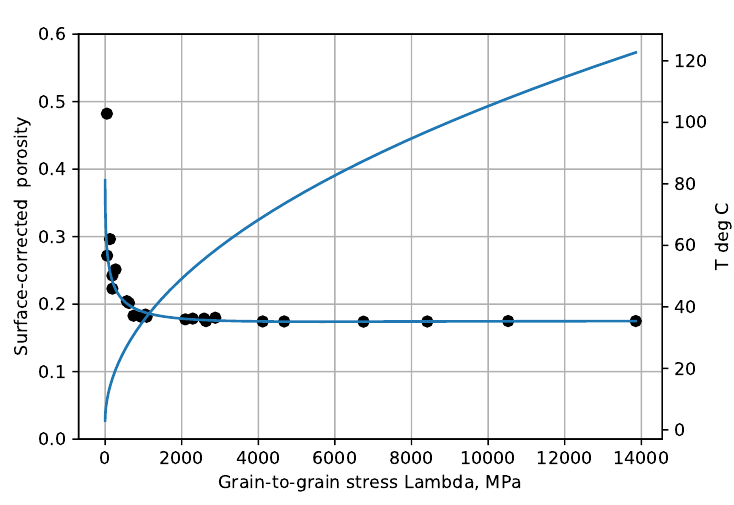
Figure 15. Makran2.